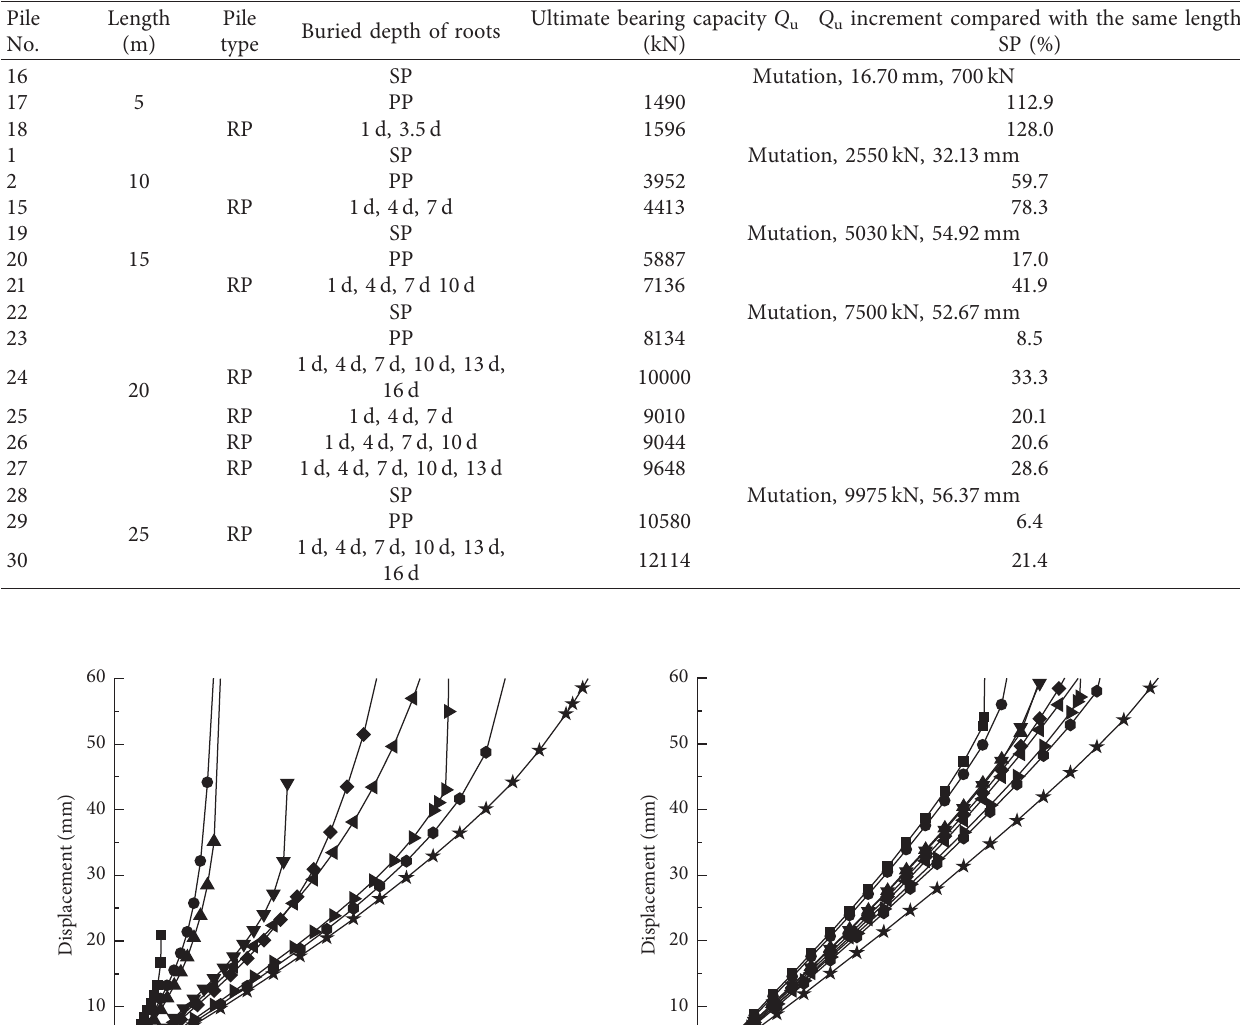
Table 3: Simulation programs and results of piles with different length.